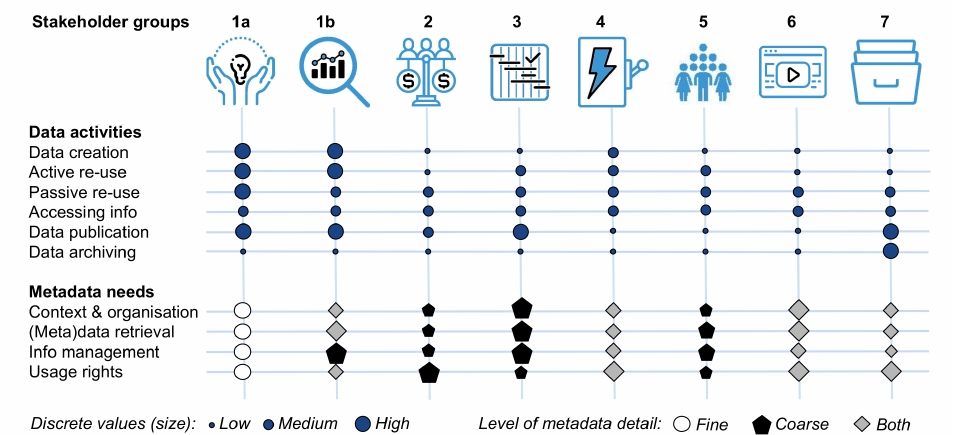
Figure 2. Data activities and metadata needs for each stakeholder group. 1a: Energy domain